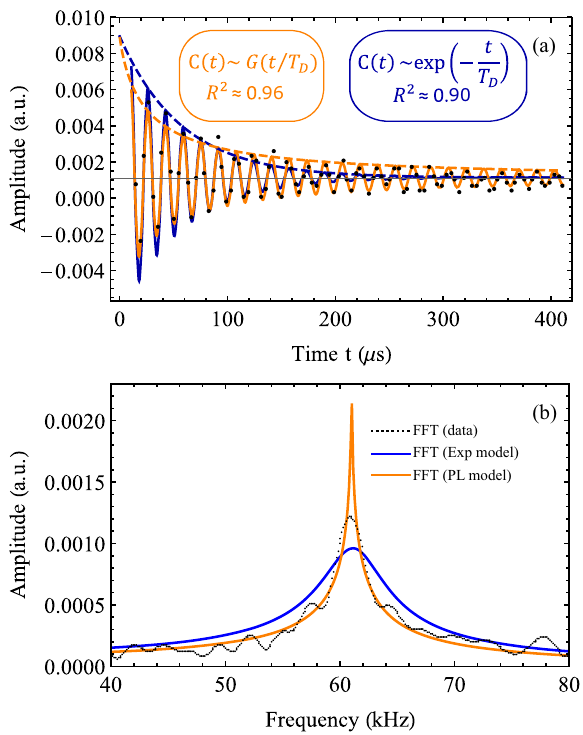
Fig. 3 Experimental data from correlation spectroscopy measure- ment with an ensemble of NV centres. ( a ) Signal of the correlation spectroscopy measurement vs. the time difference between the two DD sequences (black dots) and fi ts of the exponential (blue line) and power-law models (orange line) with their goodness of fi t and the corresponding envelopes shown as dashed lines. The power-law model shows a better fi t to the data, especially at long times. In both fi ts we fi xed the initial amplitude of the fi tted signal to an estimate from an independent power spectrum measurement. ( b ) Fast Fourier transform (FFT) of the experimental data together with the FFT from the fi tted data to the exponential and the power-law decay models, shown here for illustrative purposes. Similarly to the single NV centre experiments, the power-law model provides a better fi t of the sharp-peaked spectral line, thus allowing for better frequency